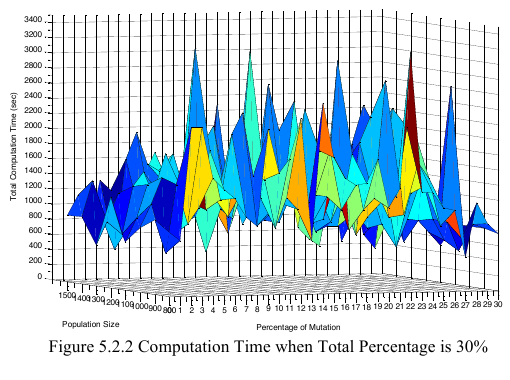
Figure 5.2.1 Generation Number when Total Percentage is 20%